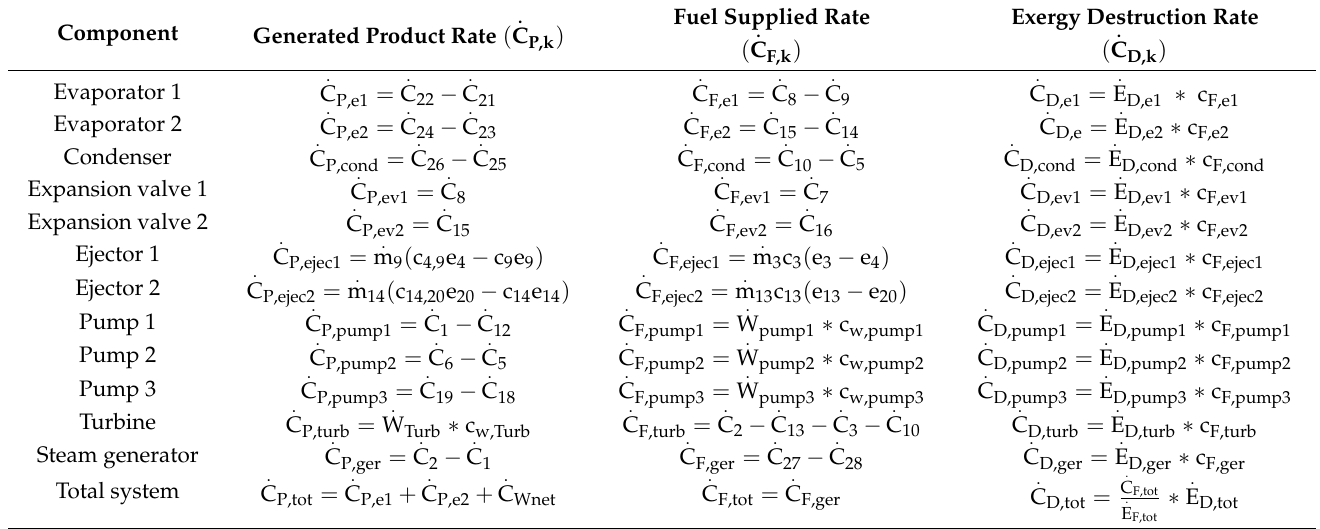
Table 5. Cost balance equations for the exergoeconomic